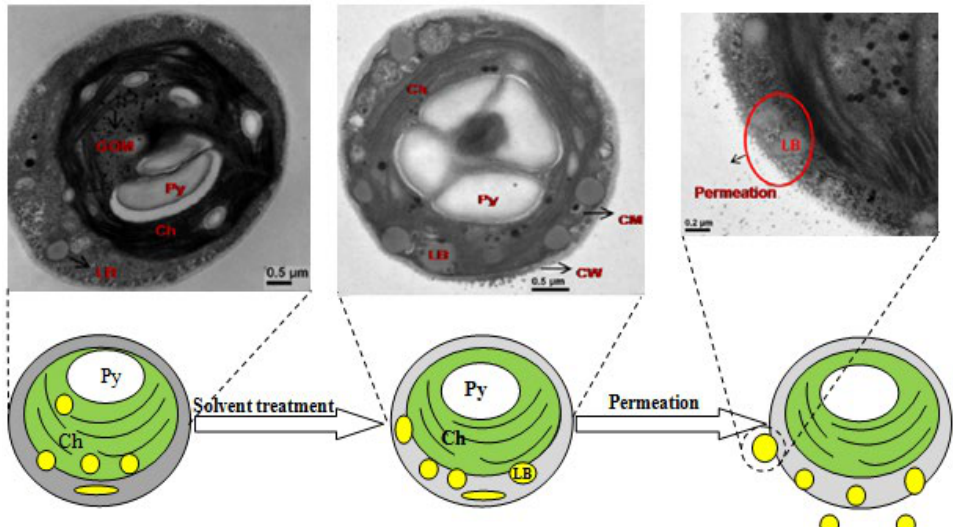
Figure 7. Schematic representation of lipid milking process from Botryococcus braunii during treatment with a biocompatible solvent, e.g., tetradecane (Ch: chloroplast; Py: pyrenoid; LB: lipid body; CW: cell wall; CM: cell membrane; GOM: granular osmiophilic material). The upper panel shows the TEM image of the microalgae. Adapted with permission from [96].